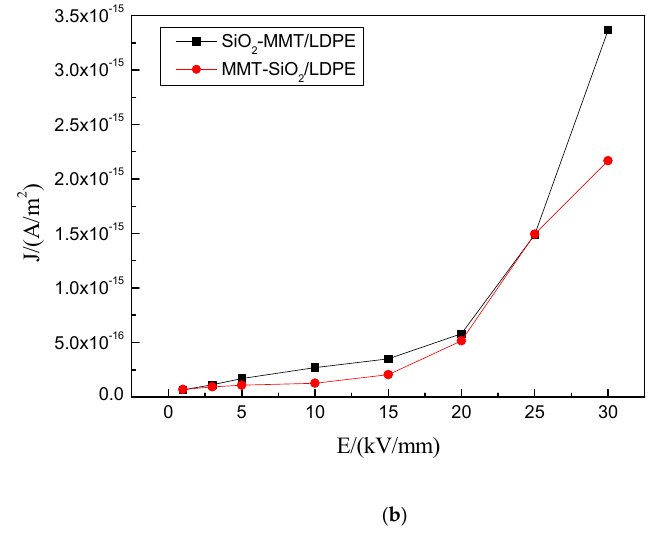
Figure 5. Curve of the conductance current of LDPE and composite materials changing with the field intensity. ( a ) The relationship between conductance current and field intensity of LDPE, MMT/LDPE, and SiO 2 /LDPE; ( b ) The relationship between conductance current and field intensity of SiO 2 -MMT/LDPE and MMT-SiO 2 /LDPE.